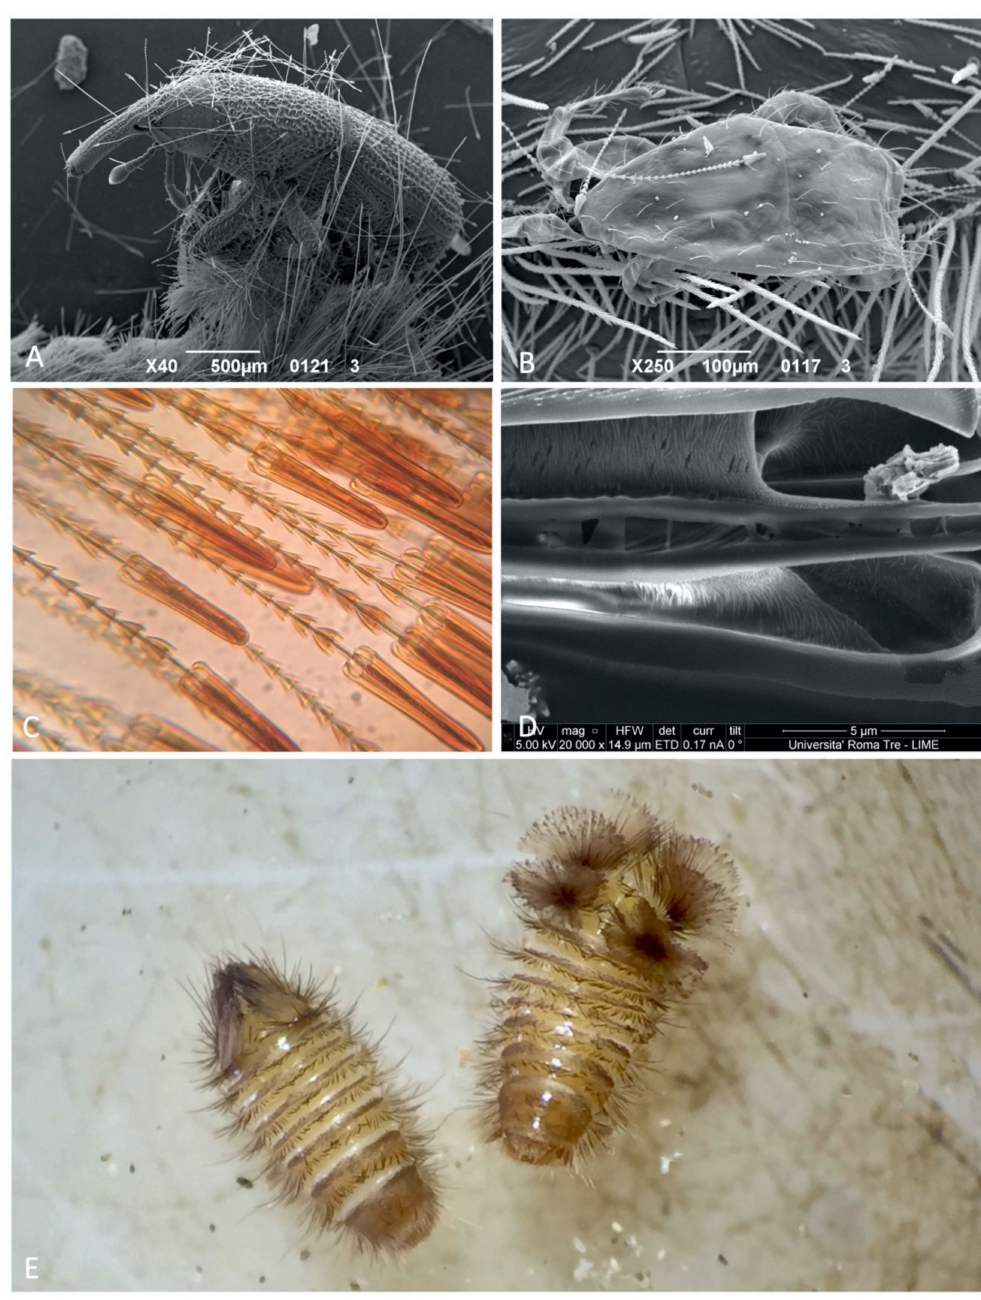
Figure 5. ( A ) SEM photo of a Sitophilus spp. (Curculionidae) trapped on the exuvia of Megatoma undata ; ( B ) SEM photo of a Mesostigmata mite entangled by hastisetae on a larva of Trogoderma spp. 1; ( C ) Hastisetae of Megatoma undata mounted in Euparal showing the darker, empty core; ( D ) SEM photo of a section of the head of the hastisetae of Trogoderma variabile illustrating the internal cavity of the stalk filled with the amorphous matrix; ( E ) Larvae of Anthrenus spp.: left specimen in a relaxed condition and hastisetae at rest; right specimen displaying defensive behavior with raised